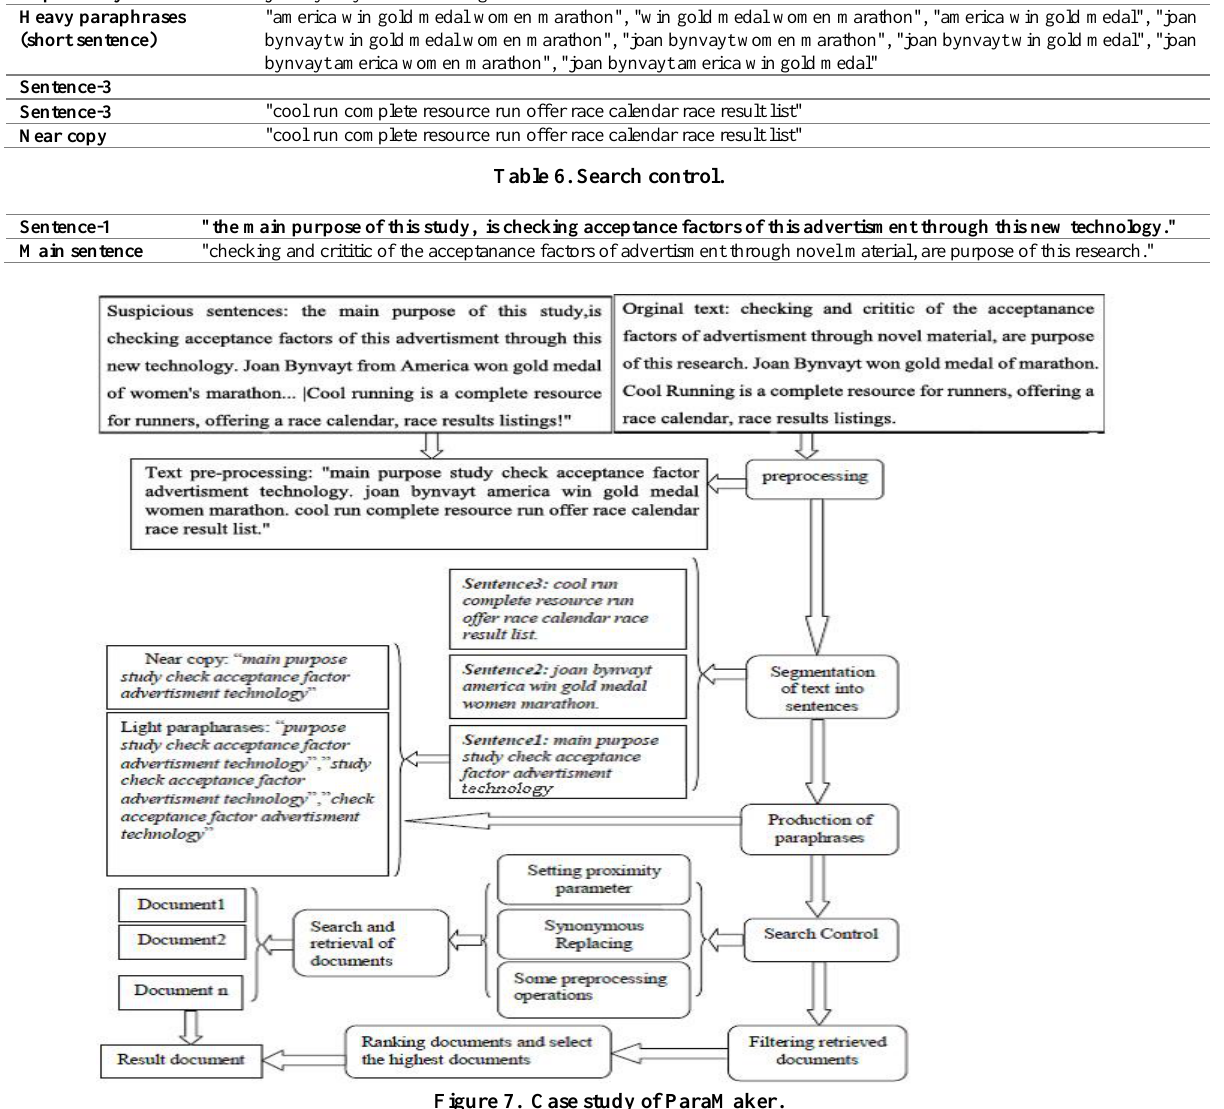
Table 6. Search control.